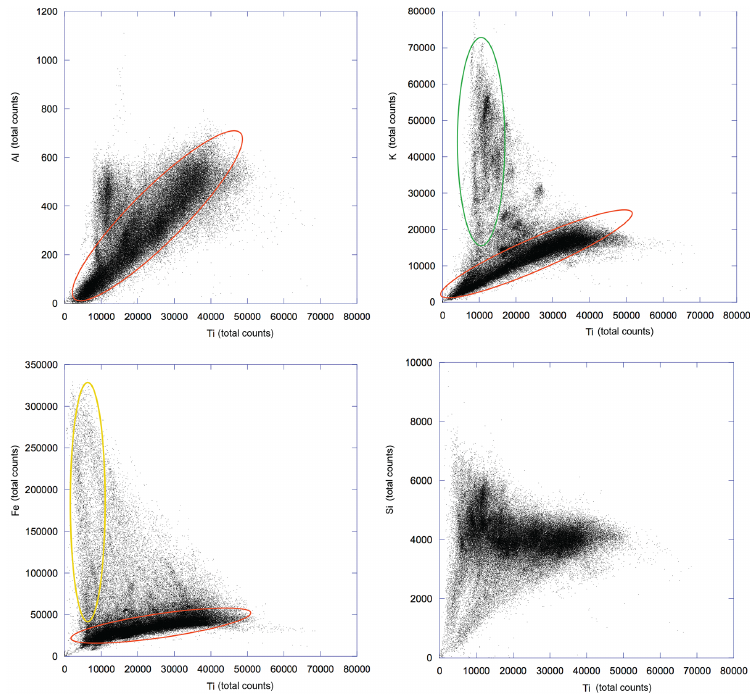
Figure 5. Scatter plots for major terrigenous elements as derived from µXRF measurements. Red ellipses indicate the range of values for elements ratios corresponding to the terrigenous component. The green ellipse shows the range K / Ti ratio values biased by tephra layers (volcanic ash) and the yellow ellipse marks the range of values of Fe / Ti ratio that indicate the presence of siderite precipitation and volcanic